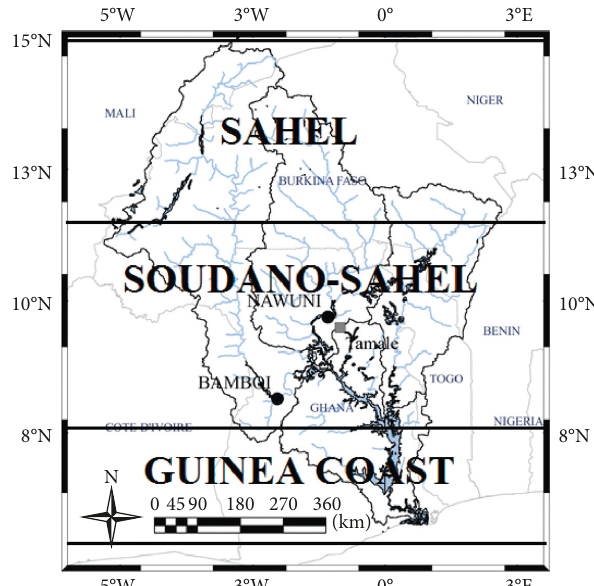
Figure 1: The three ecological zones in the basin, from the humid Guinea Coast to the semiarid Sahel (modified from Fujihara et al.